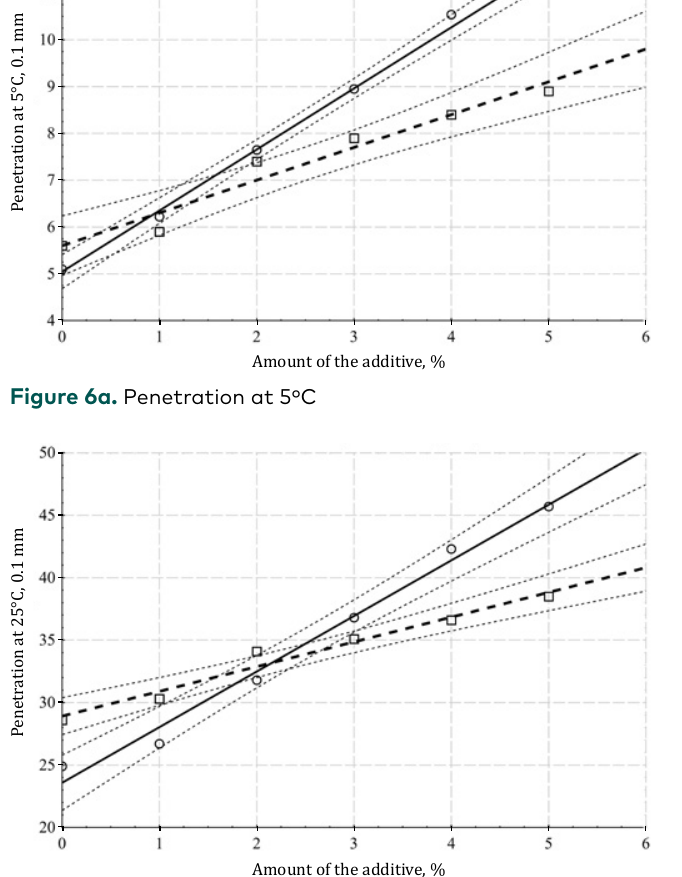
Figure 6b. Penetration at